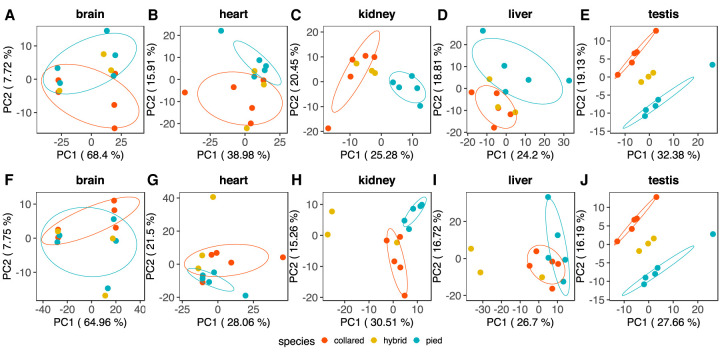
Principal component analysis plots of the first two principal components of variation in gene expression in five different tissues for five collared flycatchers (red), five pied flycatchers (blue), and three F1 hybrids (yellow). Ellipses indicate the species-specific mean with a range of ±1 standard deviation, in red for collared flycatchers, in blue for pied flycatchers. Note that a sample size of three does not allow computing ellipses for the F1 hybrids. (A–E) F1 hybrids are projected onto the PCA of the parental species. (F–J) F1 hybrids are directly included in the PCA.